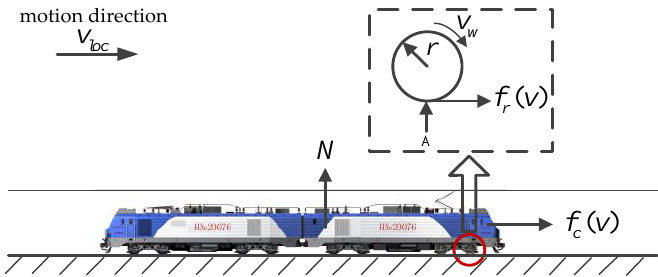
Figure 1. An analytical schematic of a locomotive’s three forces.